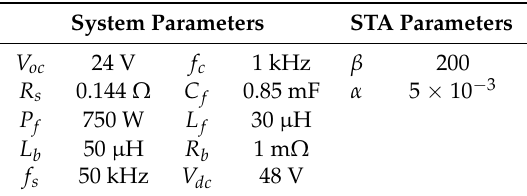
Table 1. Parameters of the simulated power